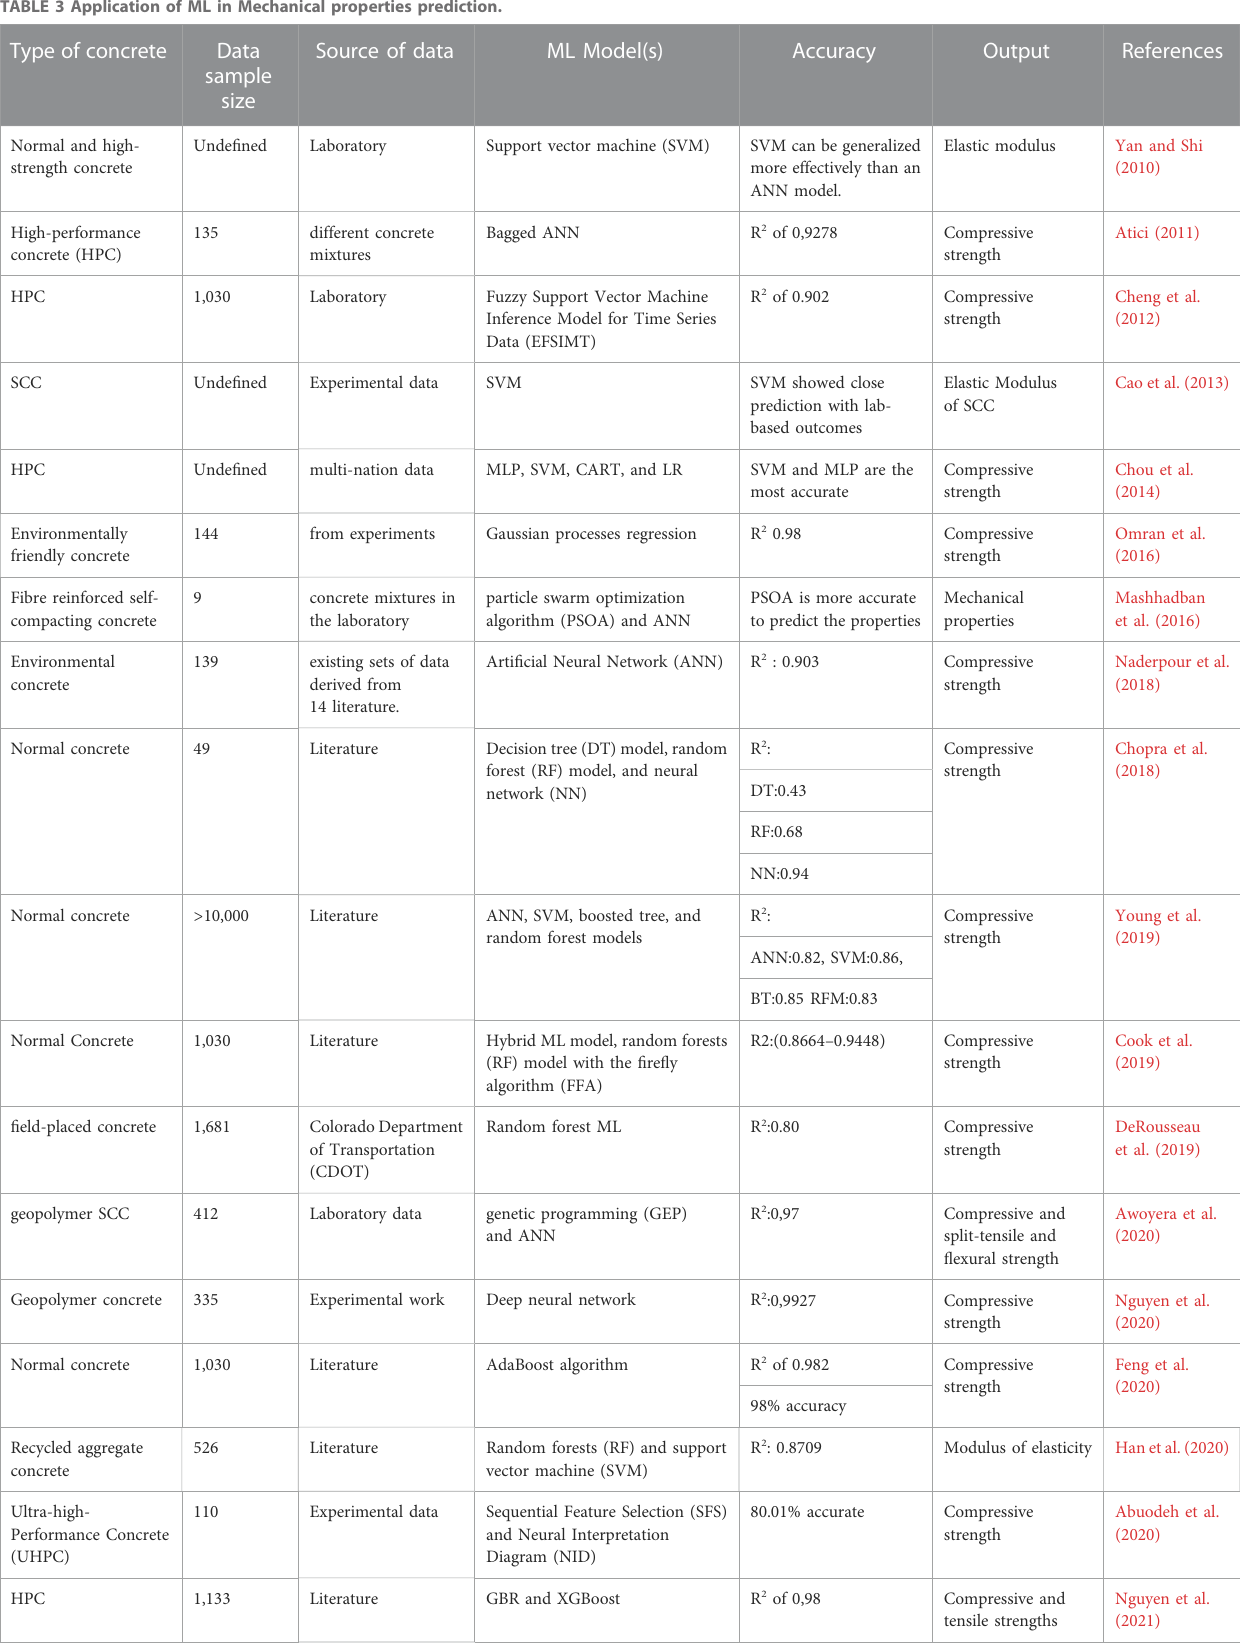
TABLE 3 Application of ML in Mechanical properties